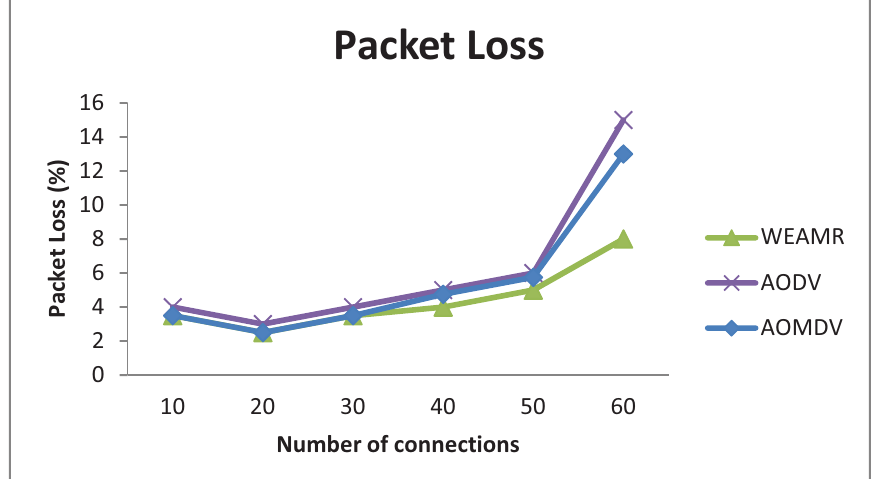
Figure 11. Average packet loss in end to end with increasing number of